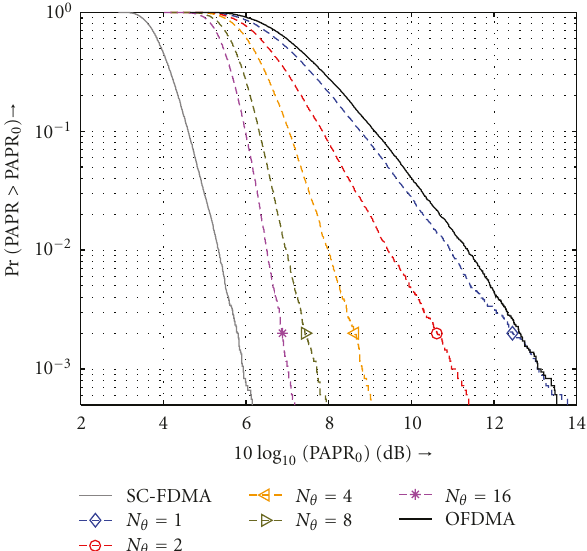
Figure 6: PAPR for SC-FDMA transmission without power allocation (solid gray), SC-FDMA transmission with beamforming and power allocation for LE ( E b /N 0 = 7 dB) (dash-dotted), and OFDMA transmission (solid black) for a Pedestrian B channel profile.